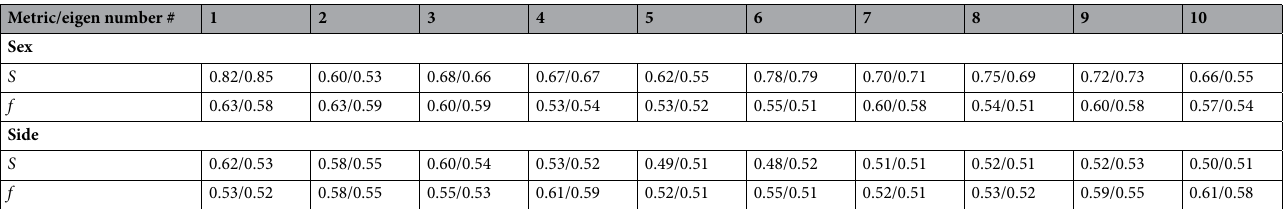
Table 1. Sex and side classification accuracy ACU/AUC of different metrics for model FEMP-I. The CI95% are not shown due to readability, but generally are in range 0.05–0.17.